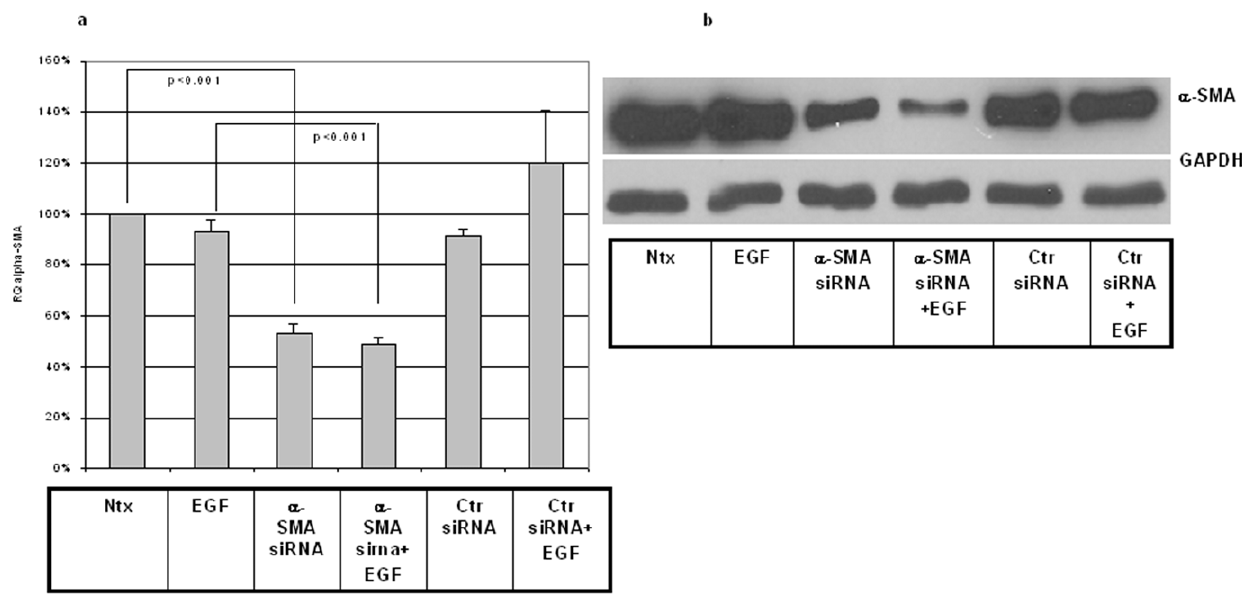
Figure 10. siRNA against a -SMA specifically decreases both both basal and EGF- induced mRNA and protein levels of a -SMA in adult fibroblasts. (a) qRT-PCR analysis of a -SMA mRNA levels showed effective inhibition of both basal expression and EGF-induction in siRNA- transfected adult fibroblasts. Results are expressed as relative quotient (RQ) of measured a -SMA mRNA and were calculated as a percentage of baseline control levels (100%). Values are means 6 SEM of six independent studies, each performed in duplicate. Statistical analyses were performed with Student’s t test. Ntx- no transfection; EGF-EGF treatment (1 nM); siRNA-treatment with a -SMA siRNA; Ctr- treatment with a non-specific control siRNA. (b) Western blot results using a -SMA antibody (1:500) showed effective reduction of a -SMA protein levels when siRNA was administered but no decrease when non-specific control siRNA was employed. GAPDH was used as a loading control. A representative immunoblot of up to four similar such blots is shown for each